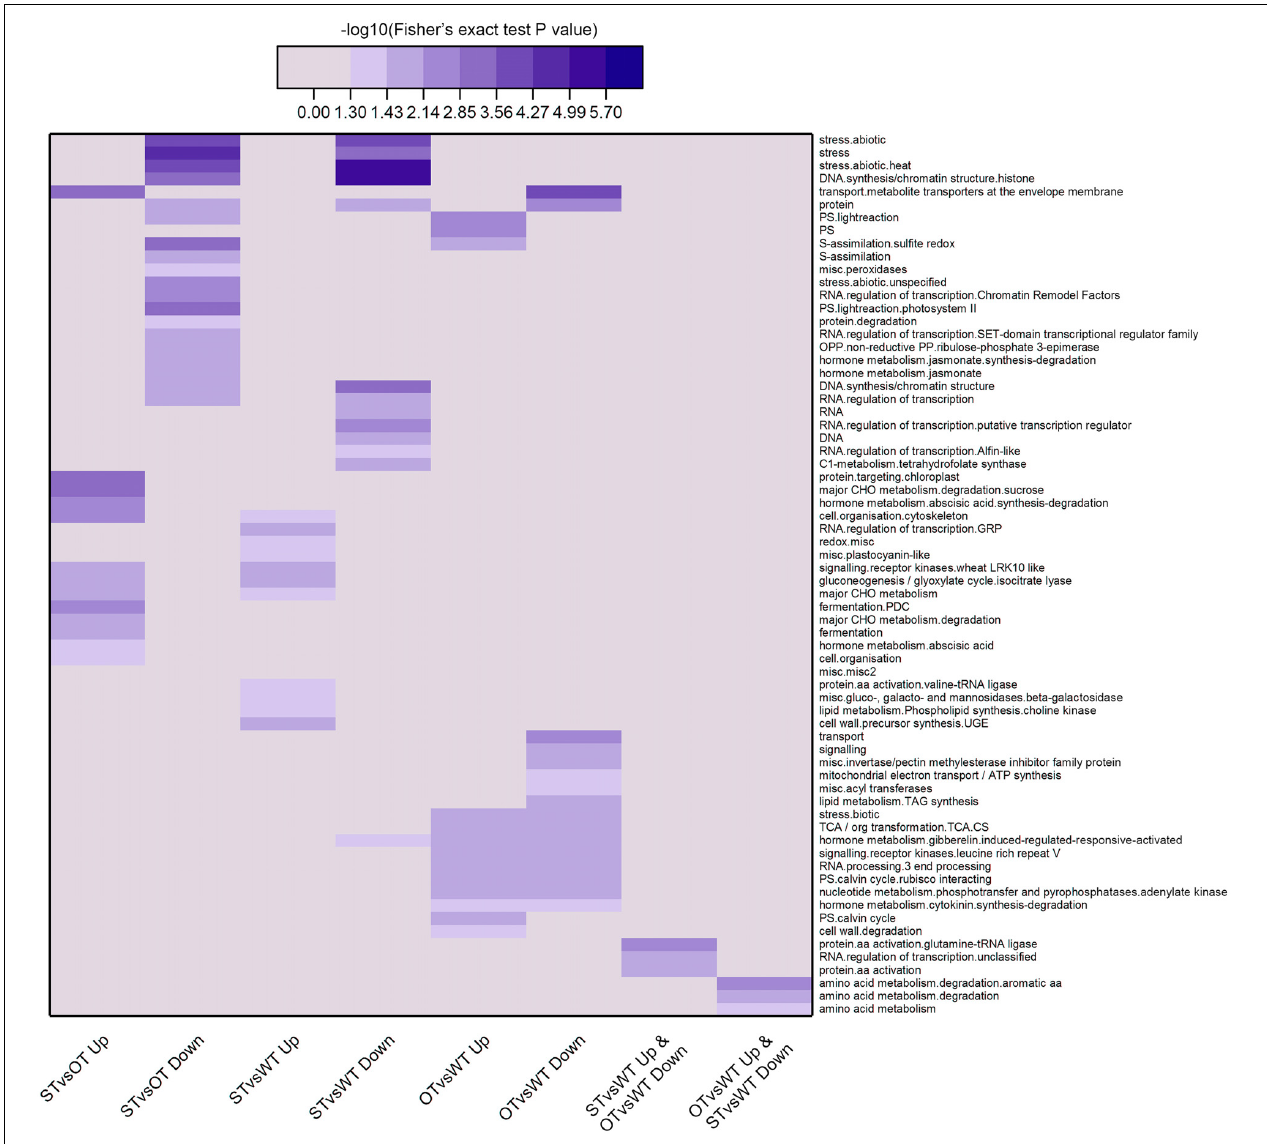
FIGURE 5 | Clustering analysis of the results of MapMan pathway enrichment of genes corresponding to the DEPs identified in the WT, ST, and OT seeds. The darker the color, the more significant the degree of enrichment. The DEPs were selected based only on fold-change (FC > 1.3 or < 1/1.3), and not on the basis of the P